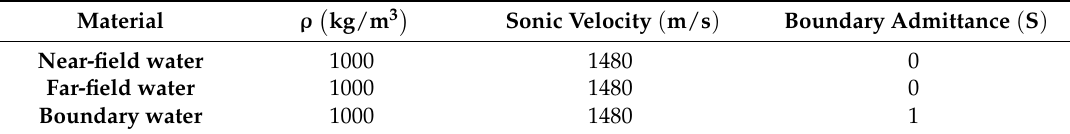
Table 5. The specific values of water environment.